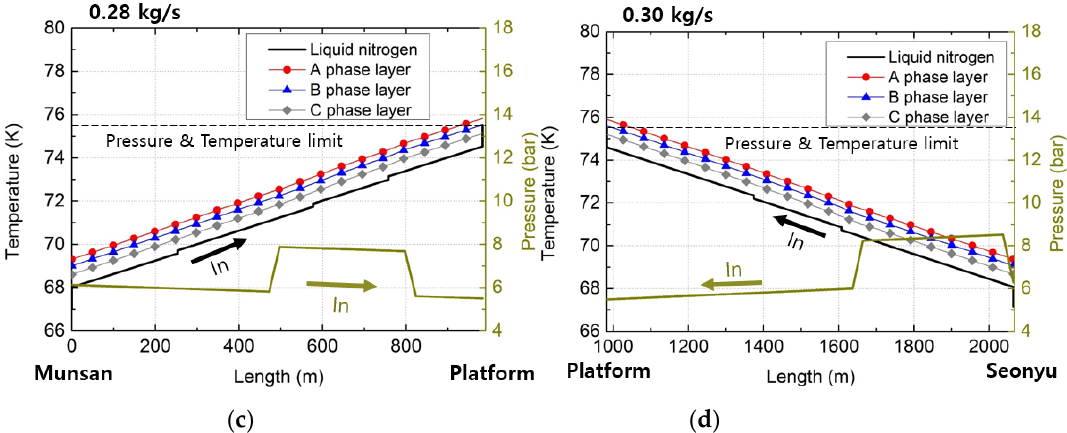
Figure 9. Temperature and pressure variations along the HTS power cable with an external return path: ( a ) single cooling system at Munsan; ( b ) single cooling system at Seonyu; ( c ) dual cooling system, Munsan side; ( d ) dual cooling system, Seonyu side. The mass flow rates are minimum values that meet the allowable temperature difference.